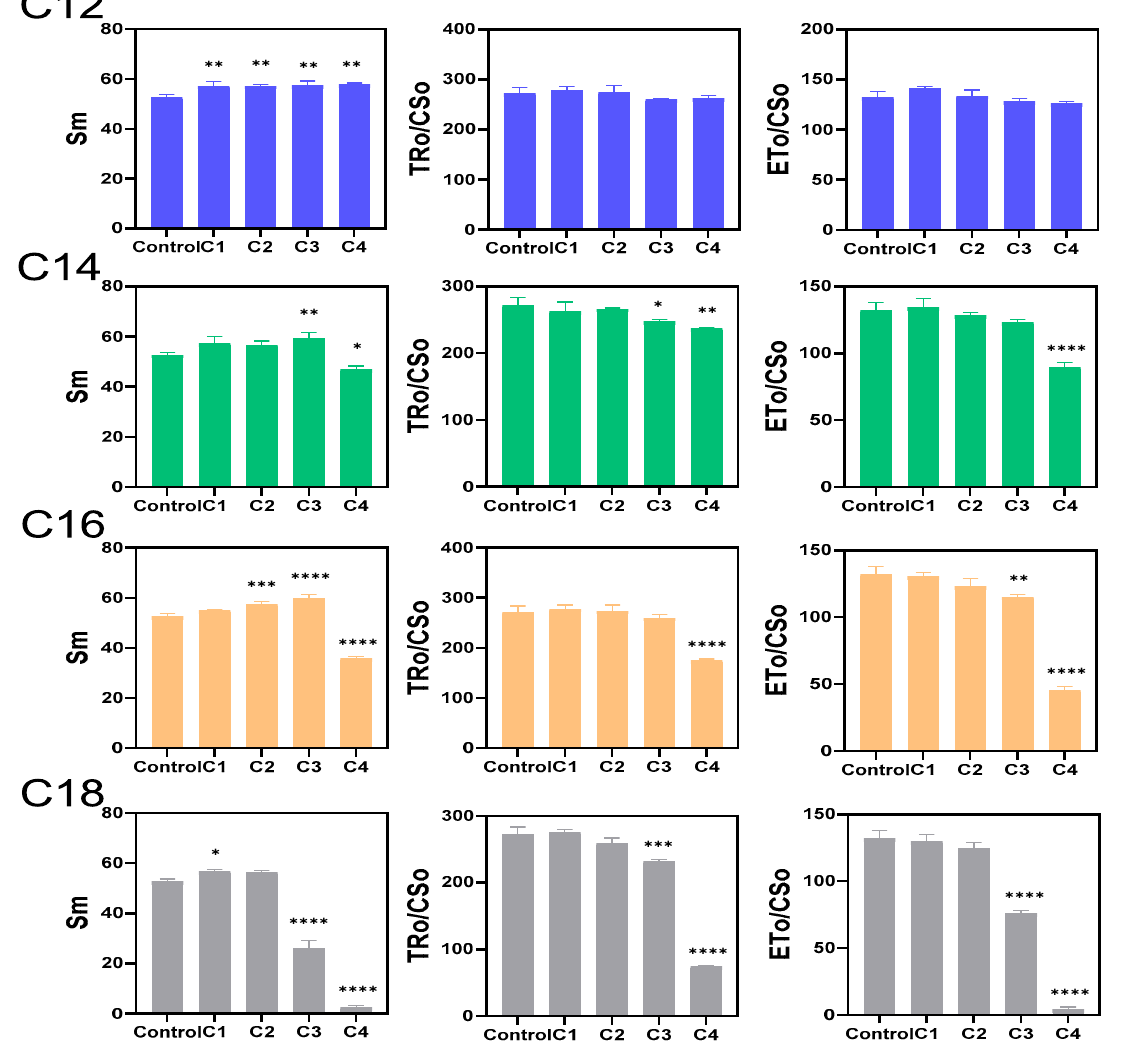
Figure 1. Effect of different ATMA-Br (C12–C18) and their concentrations (C1: 0.59 µ M; C2: 1.78 µ M; C3: 5.33 µ M; C4: 16 µ M) on three OJIP fluorescence parameters following 3 h exposure. Sm (the sum of area between multiple turn-overs of the OJIP curve) is calculated by the area between the OJIP curve and F = Fm line, indicating the total energy for receptor reduction. TR O /CS O indicate the trapped energy flux per cross-section at t = 0) and ET O /CS O indicates electron transport flux per cross-section at t = 0. A full presentation of OJIP fluorescence parameters was shown in Figure S2. Error bars indicate the standard deviation (n = 3). The asterisk indicates statistically significant differences in comparison with the control: * p < 0.05; ** p < 0.01; *** p < 0.005; **** p < 0.001.